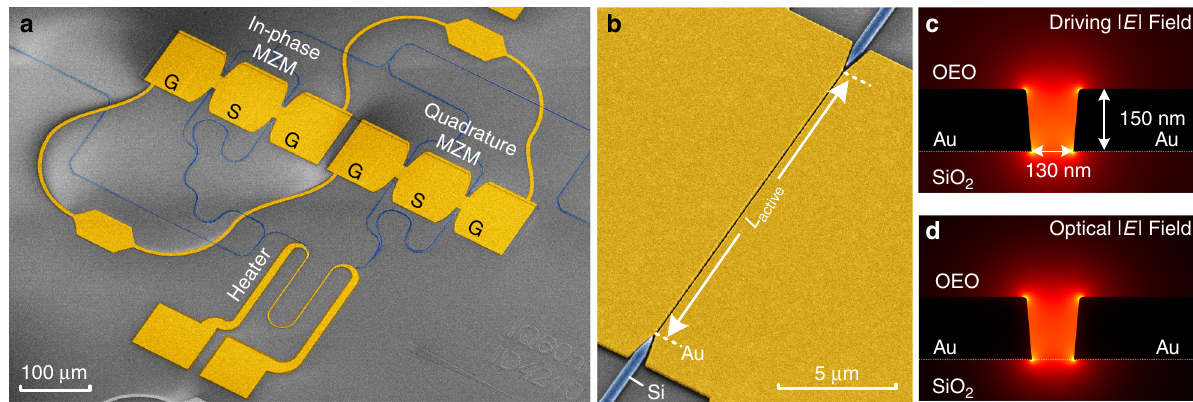
Fig. 1 Plasmonic IQ modulator on the silicon platform. a Colorized scanning electron microscope picture of a plasmonic IQ modulator consisting of two Mach-Zehnder modulators (MZMs). b Zoom into the active section of the modulator, a plasmonic slot waveguide. Light from silicon (Si) feeding waveguide is coupled to the gold (Au) slot waveguide by tapered mode converters. The slot is fi lled with an organic electro optic (OEO) material (not depicted). c , d Cross section of the plasmonic slot waveguide with simulated c electrical driving fi eld and d optical